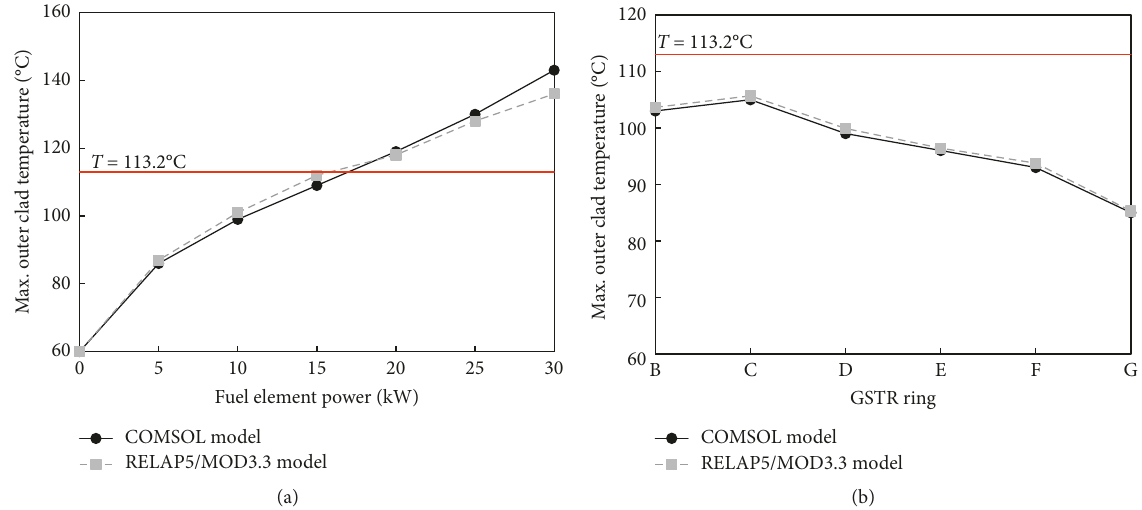
Figure 13: Calculated outer clad temperatures in the fuel elements with stainless steel cladding versus the (a) fuel element power and (b) GSTR